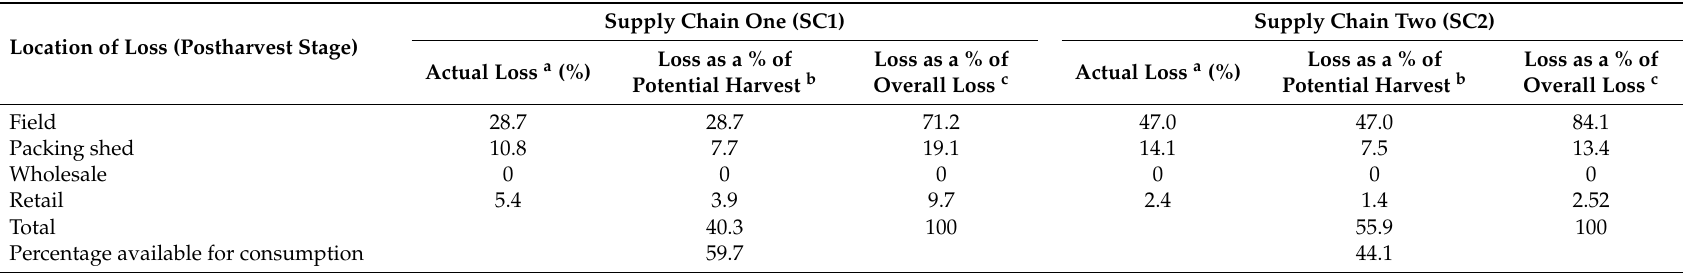
Table 3. Percent of actual and cumulative losses by location within the supply chain where postharvest loss was determined, and calculation of the percentage of harvested product made available to the